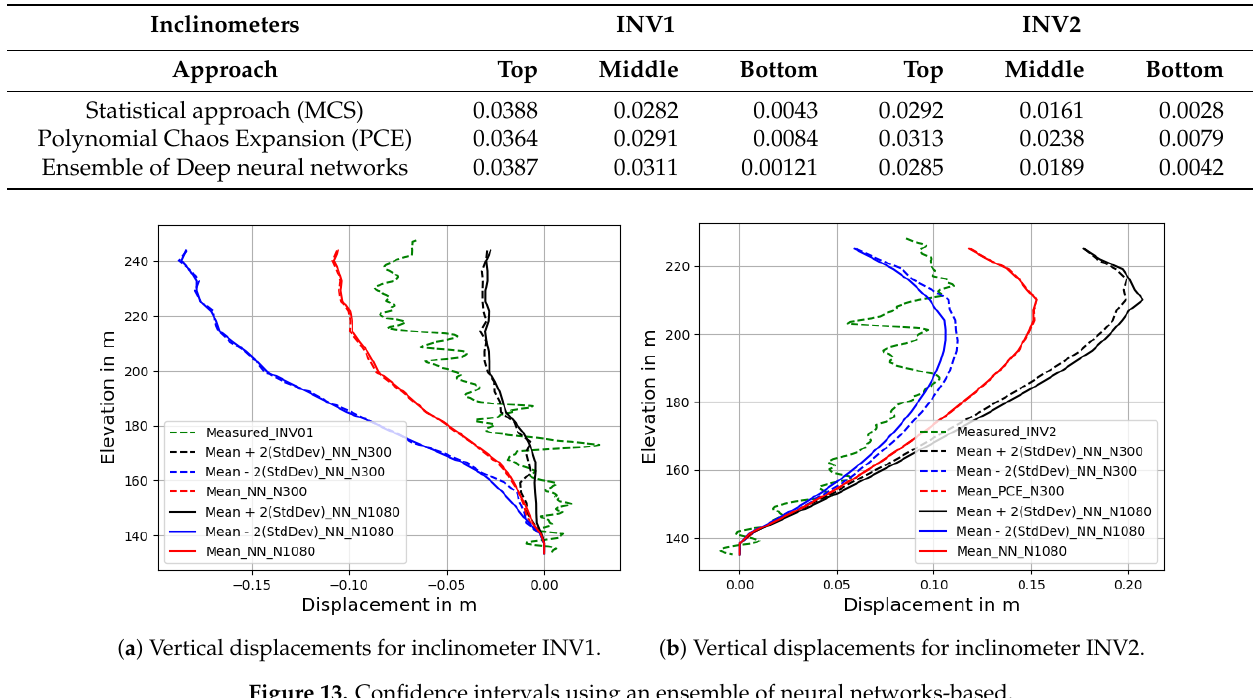
Figure 13. Confidence intervals using an ensemble of neural networks-based.